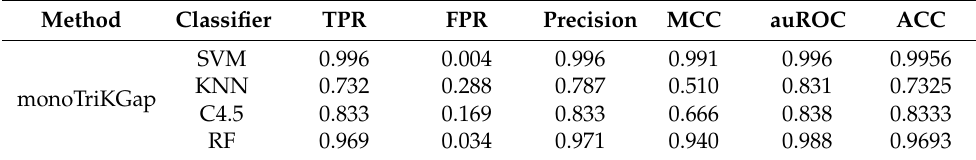
Table 5. Comparison of features extracted by monoTriKGap under other classifiers.